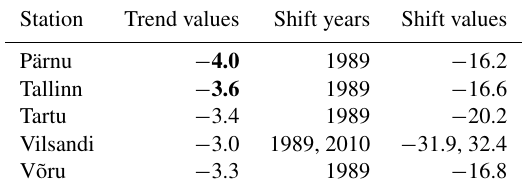
Table 5. Trend values, years of regime shifts and corresponding shift values of snow cover duration. Statistically significant trends at p <0.05 are in bold. Shift